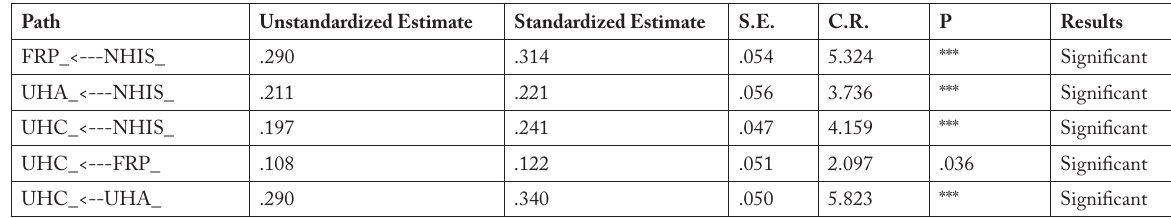
Table 9. Direct hypothesis test.